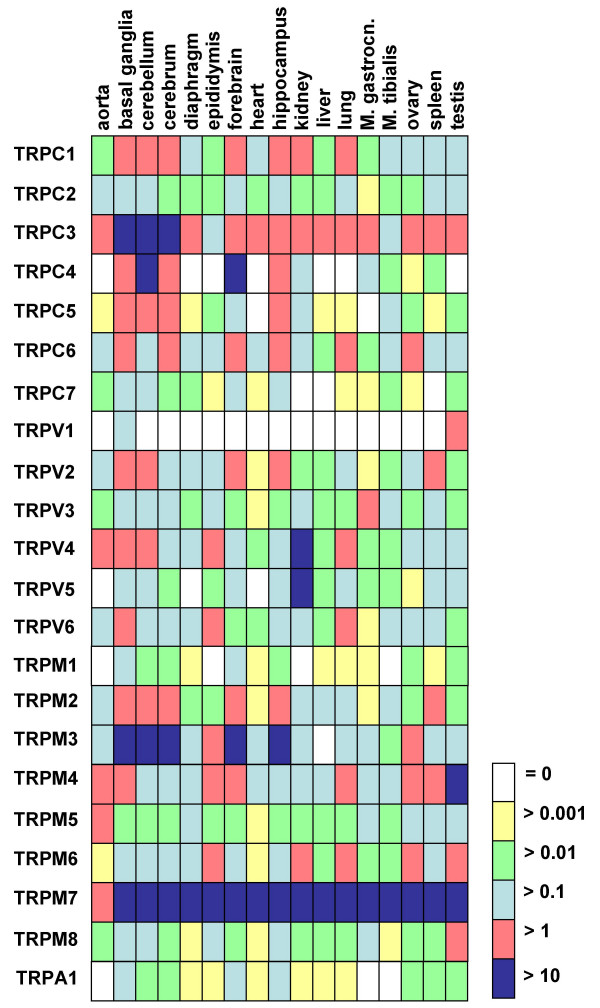
Summary of tissue specific TRP channel gene expression. Expression of TRPC1-7, TRPM1-8, TRPV1-6 and TRPA1 mRNAs in murine tissues was determined by real-time RT-PCR. Levels of mRNAs are given in relation to that of 18S rRNA; all data were multiplied by 1000. Means were calculated from n = 3–10 samples and classified into 5 categories. If the threshold level of fluorescence according to the TaqMan RT-PCR technique was not reached after 40 cycles of amplification, a resulting expression level of zero (0) was assigned to the corresponding channel transcript and tissue. For better illustration categories of gene expression levels are represented by different colors ranging from zero (white) to values higher than 10 (dark blue).